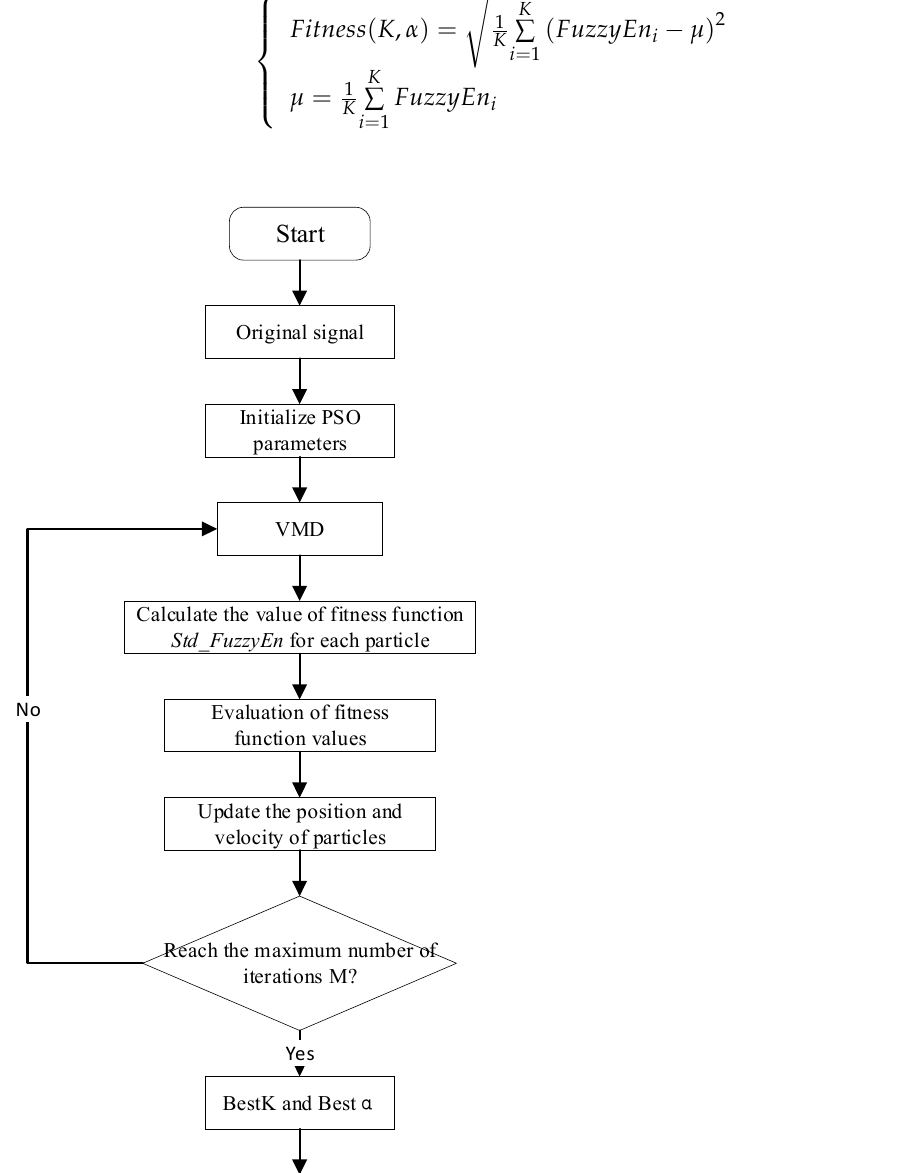
35th generation. The optimal fitness was 0.186103, and the K and α at that time were 11 and 5070.33,